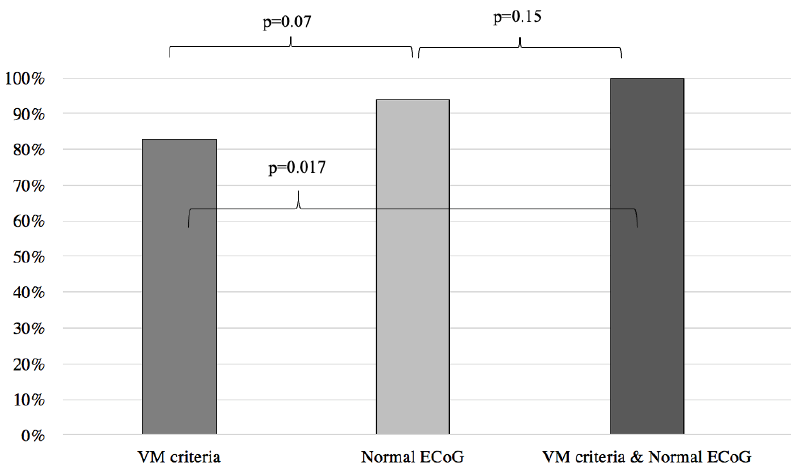
Figure 2. Symptom improvement comparison following anti-migraine treatment between patients with normal ECoG, positive VM criteria, and a combination of both. ECoG: electrocochleography; VM: vestibular migraine.